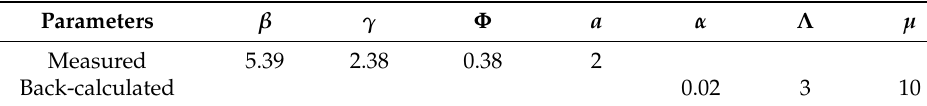
Table 3. Breakage parameters.